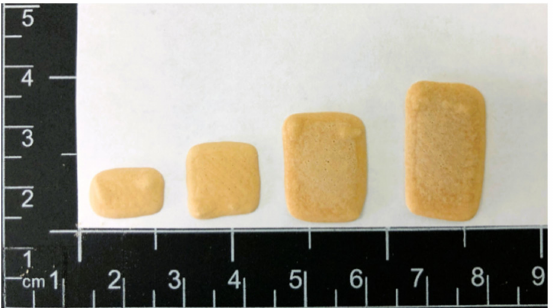
Figure 3. A photographic picture of different sized semi-solid extrusion 3D-printed theophylline- containing